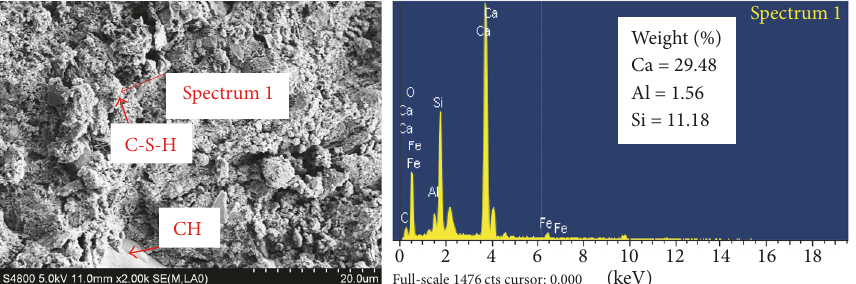
Figure 17: SEM and EDS results of OPCC in the heating group.